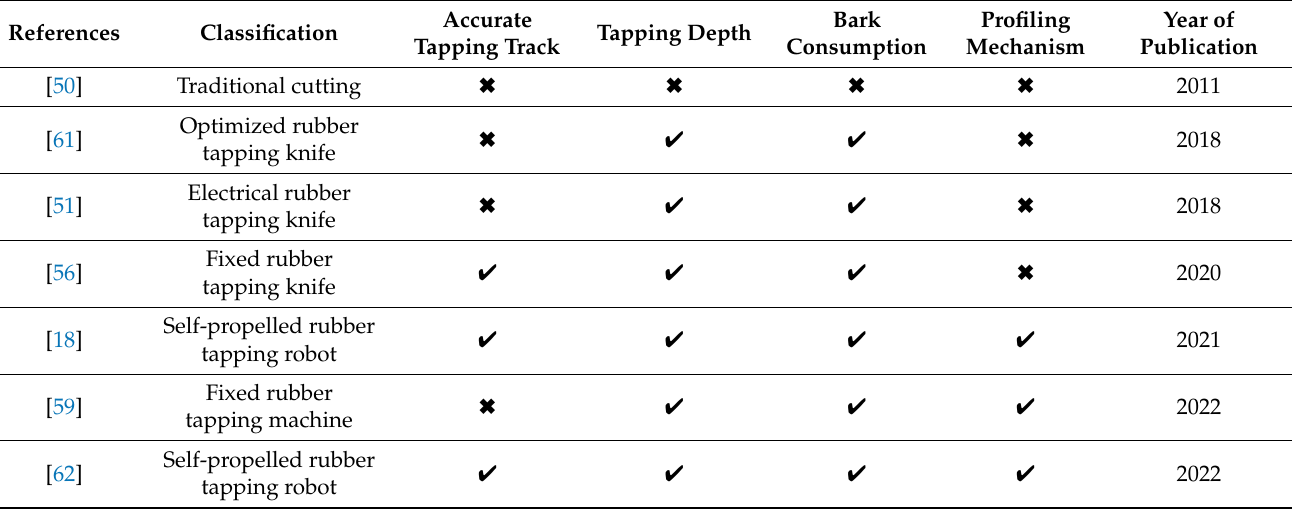
Table 2. Classification of rubber cutters and summaries of evaluation indexes used in each